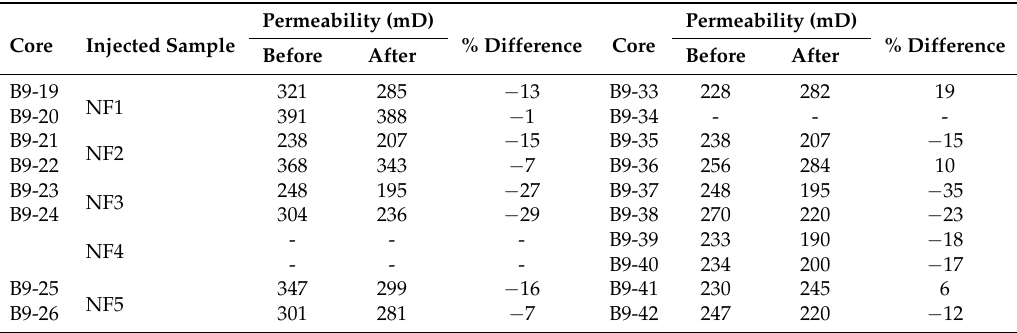
Table 7. Permeability of the cores measured before and after secondary (left) and tertiary (right) nanofluid flooding.